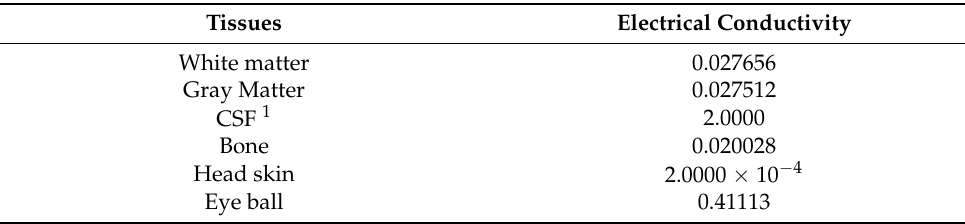
Table 1. The electrical conductivity for 10 Hz alternating current stimulation [27,28].